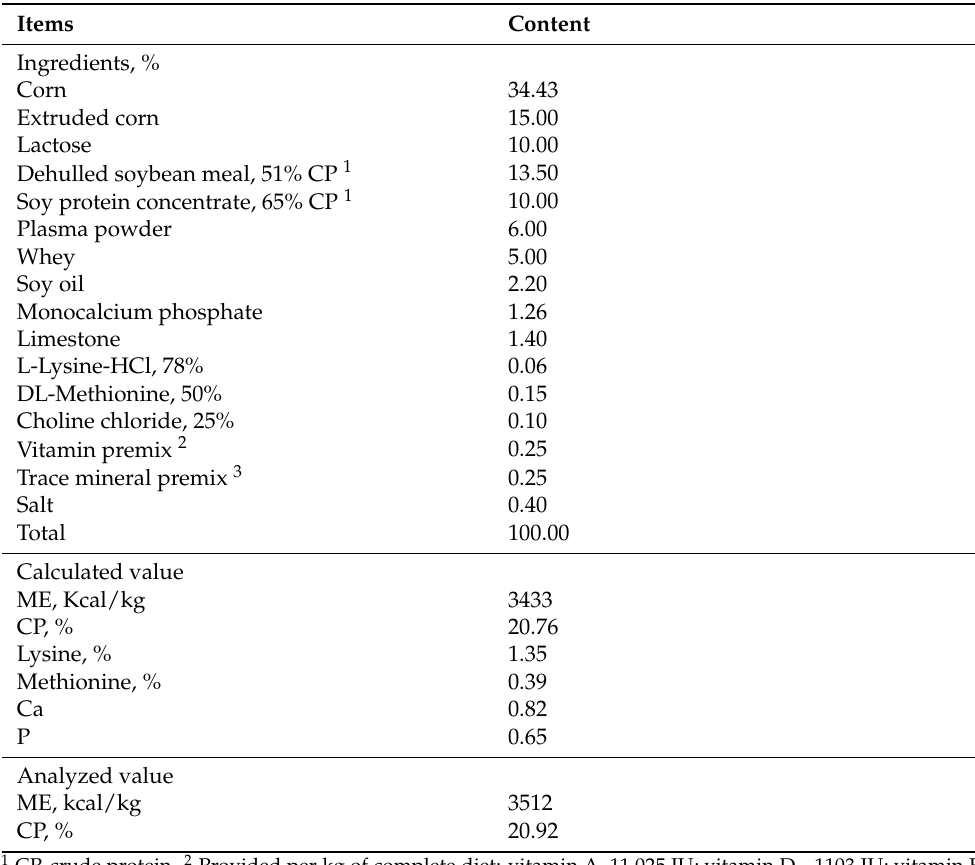
Table 1. Compositions of basal diets (as-fed basis).